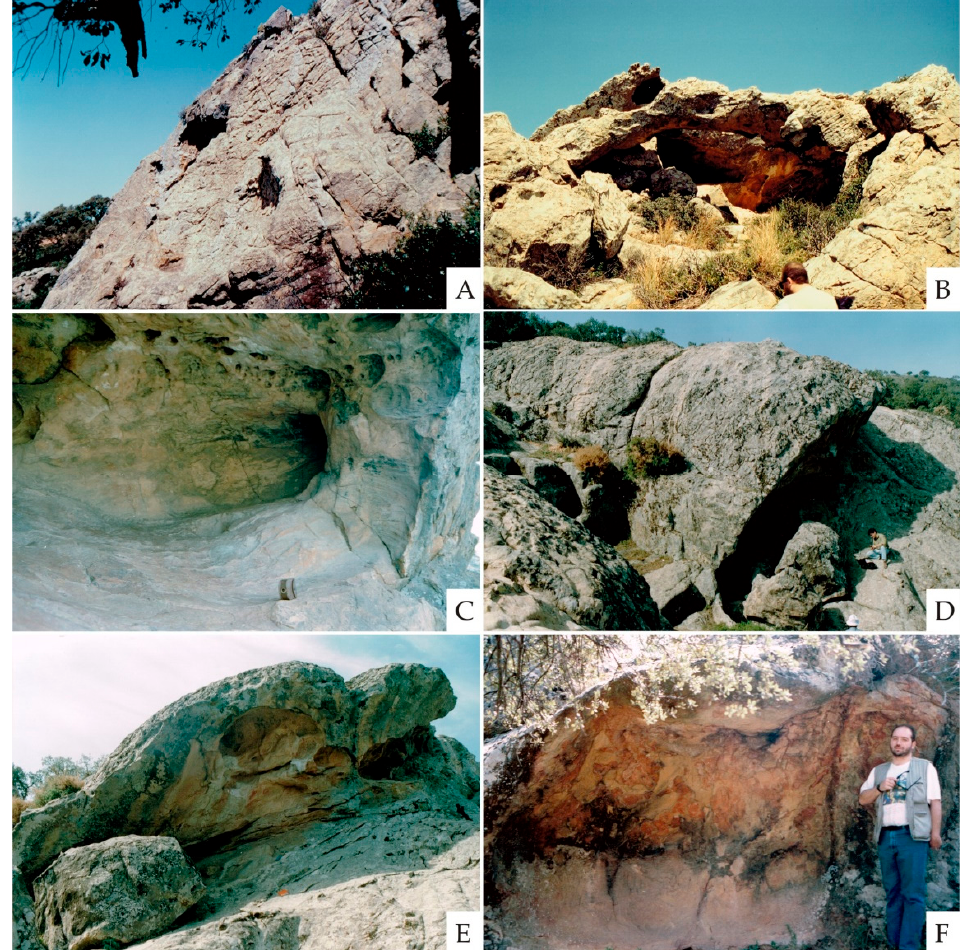
Figure 2. Morphological features of the studied rock-shelters (see text for explanation). ( A , B ) Rock Group of Tajo de las Figuras. ( C – F ) Rock Group of Peñas de Cabrera. ( A ) View of the entrance of the Cueva del Tajo de las Figuras, which is located in a fault plane; note the high number of fissures and fractures affecting the host rock. ( B ) General view of the Cueva del Arco. ( C ) View of the interior of the shelter 11; honeycomb weathering is developed on walls and ceiling. ( D ) Lateral view of shelter 13, which is developed on a fault plane. ( E ) Frontal view of shelter 13; decimetre-width tafone are developed in the uppermost part of the shelter wall. ( F ) Frontal view of shelter 17; selective weathering due to proximity to ground level is observed.